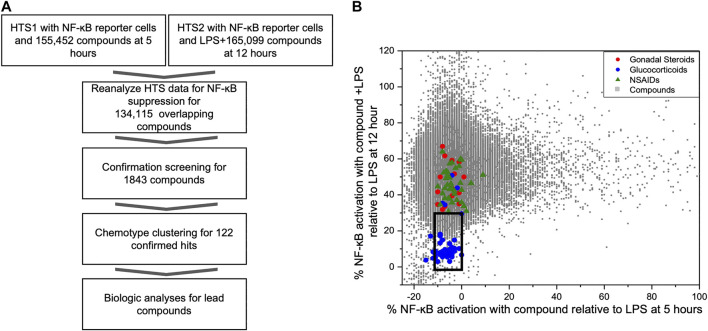
Identification of NF-κB suppressive compounds; (A) Workflow strategy for identifying NF-κB suppressive compounds by mining existing HTS data and subsequent screening strategy; (B) Distribution of NF-ĸB reporter activity from compounds screened in two prior HTS relative to known bioactive compounds. We conducted two prior HTS using the same cell-based FRET assay with THP-1 CellSensor NF-κB reporter cells. The first tested the activation/inhibition of reporter signal with compound treatment at 5 h (HTS1, x-axis), and other tested the reporter signal with LPS plus compound at 12 h (HTS2, y-axis), using 155,452, and 165,099 compound libraries, respectively. Results of the 134,115 overlapping compounds were normalized to the LPS controls in each assay and are plotted individually. Compounds in an area (black box) encapsulating known GC and below the activity of gonadal steroids or COX inhibitors (X axis -10%–0% and Y axis <30%) were picked for further assessment of immunosuppressant activity.